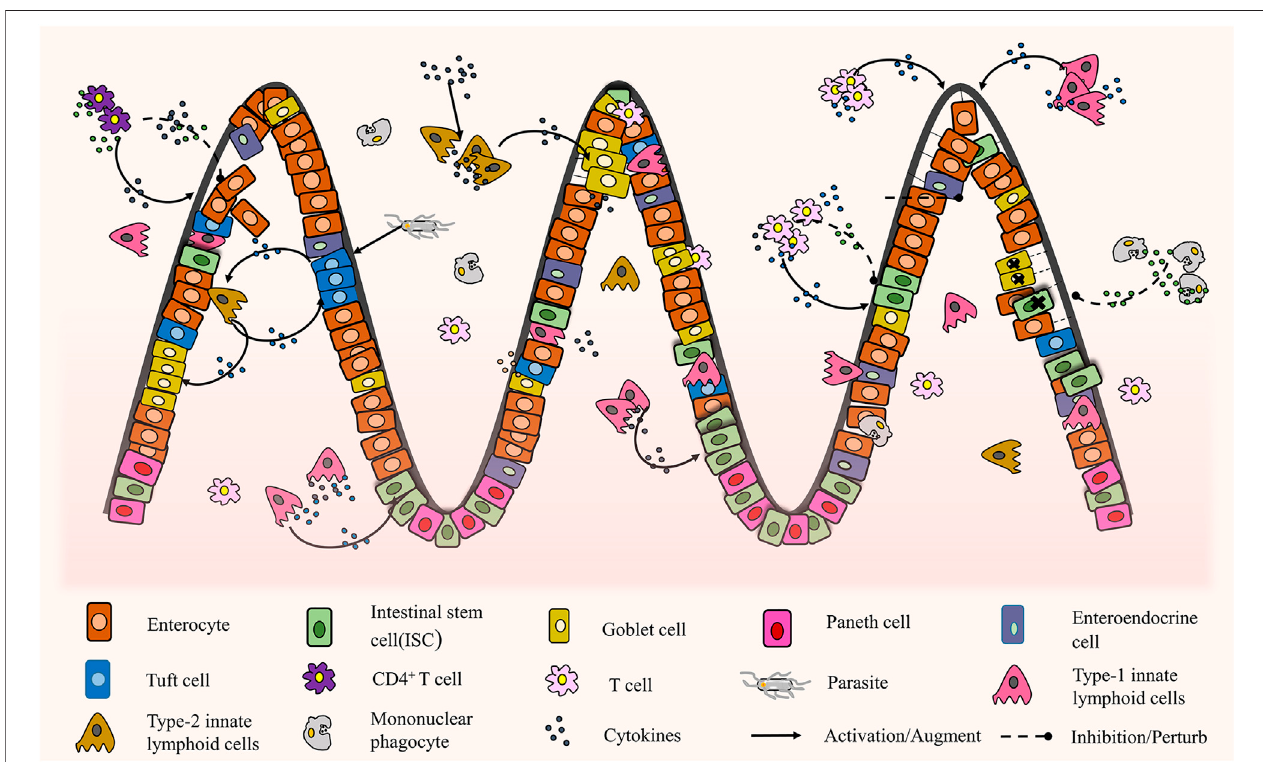
FIGURE 5 | The interaction between intestinal organoids and immune cells (Schreurs et al., 2019; Howitt et al., 2016; von Moltke et al., 2016; Gerbe et al., 2016; Nozaki et al., 2016; Waddell et al., 2019; Lindemans et al., 2015; Biton et al., 2018; Takashima et al., 2019; Jung et al., 2018; Jowett et al., 2021; Ihara et al., 2018).